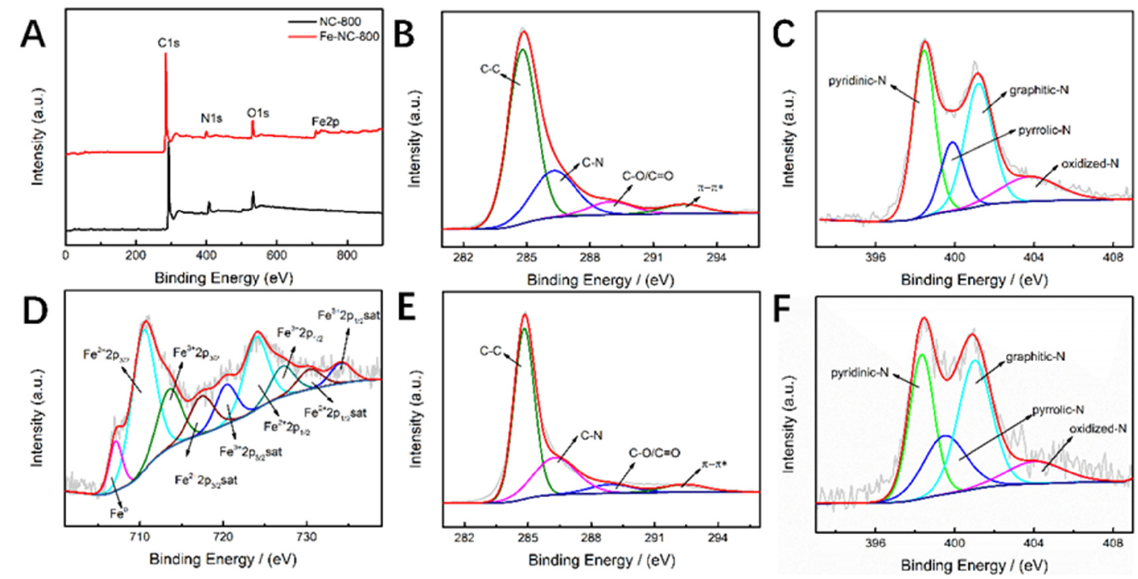
Figure 3. XPS survey spectra of prepared samples ( A ); C1s spectra of NC − 800 ( B ) and Fe − NC − 800 ( E ); N1s spectra of NC − 800 ( C ) and Fe − NC − 800 ( F ); Fe2p spectrum of Fe − NC − 800 ( D ), in Figure 3B and D, * represents bonding π electron transitions to π * orbitals.